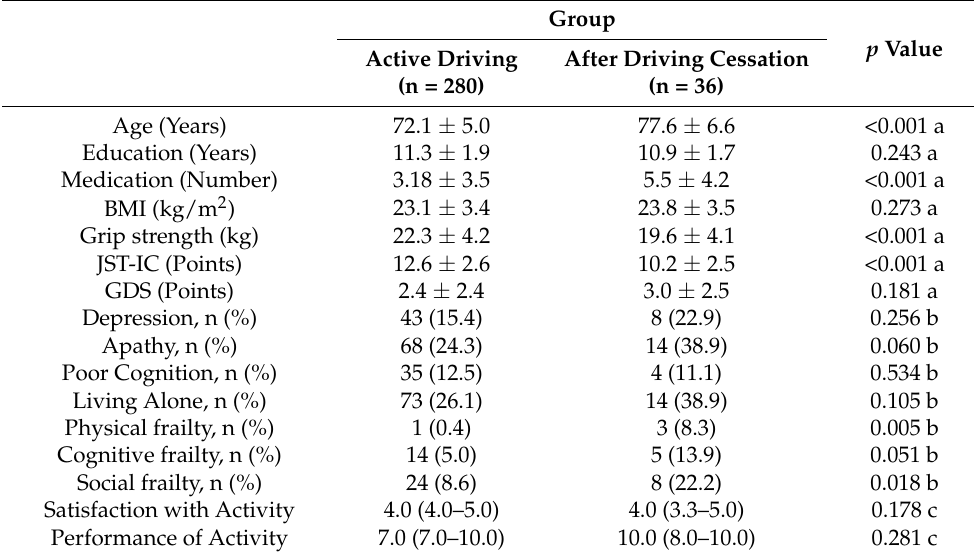
Table 3. Characteristics in the active driving group and the after driving cessation group in women.